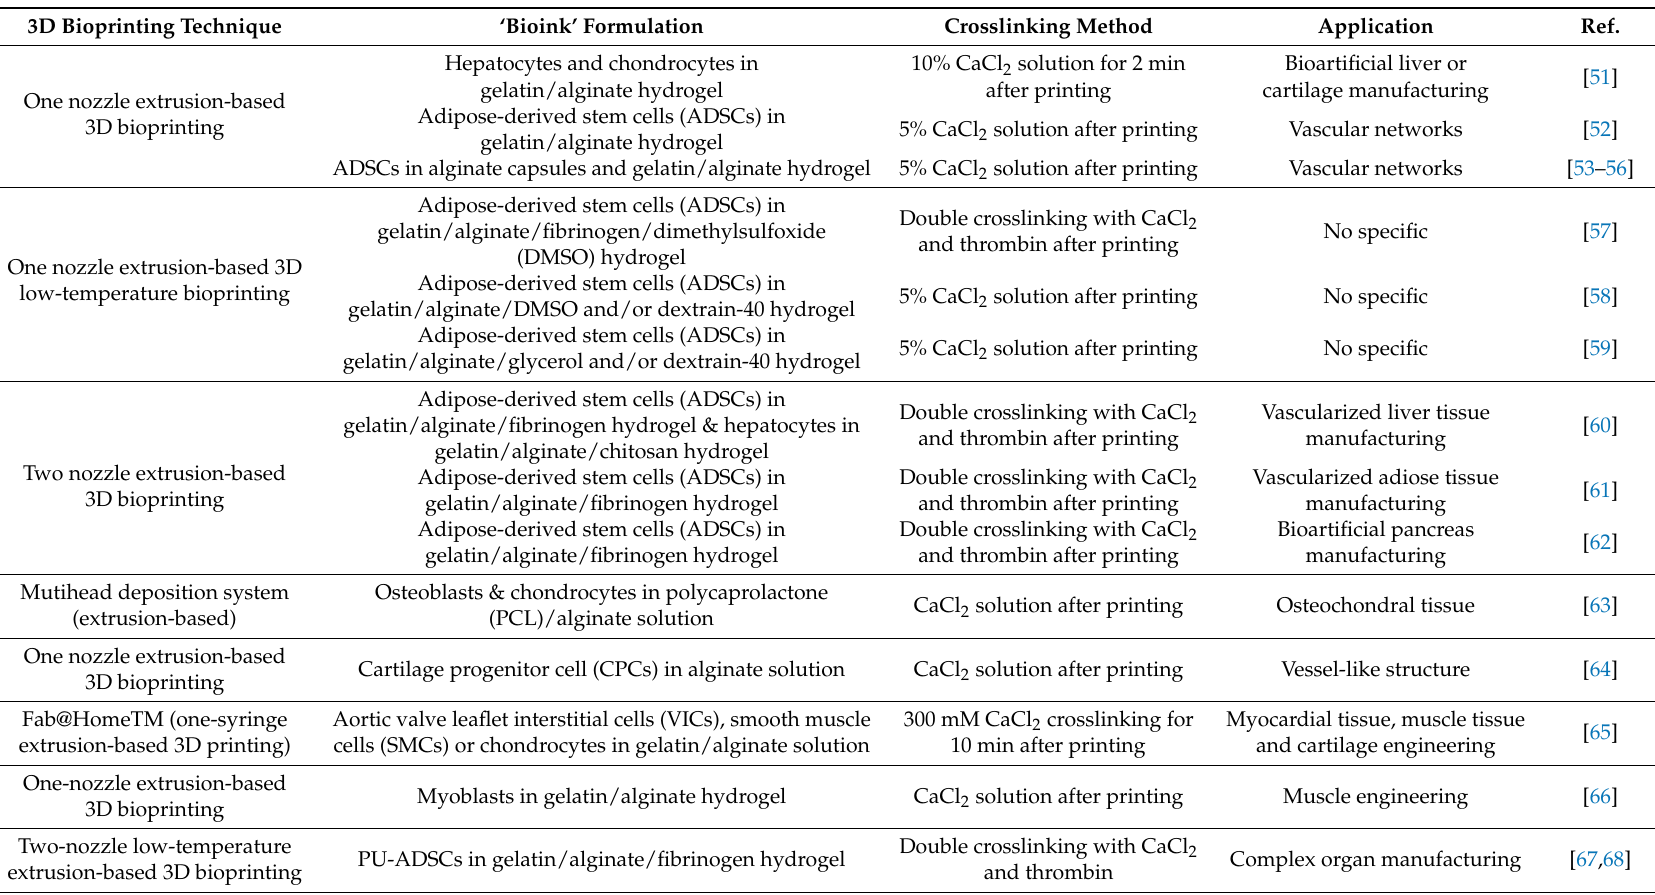
Table 2. Alginate containing ‘bioinks’ for different 3D bioprinting